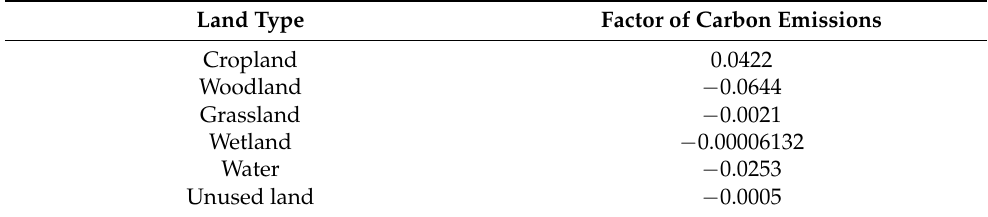
Table 1. Direct carbon emissions for various land use types (kg · m − 2 · a − 1 ) [16].